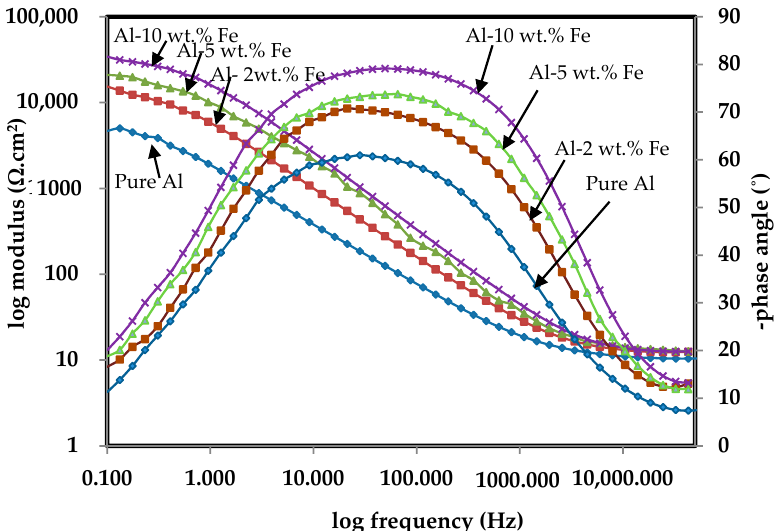
Figure 10. Bode plot for pure Al and Al-Fe alloys after one hour immersion in 3.5% NaCl at room temperature.